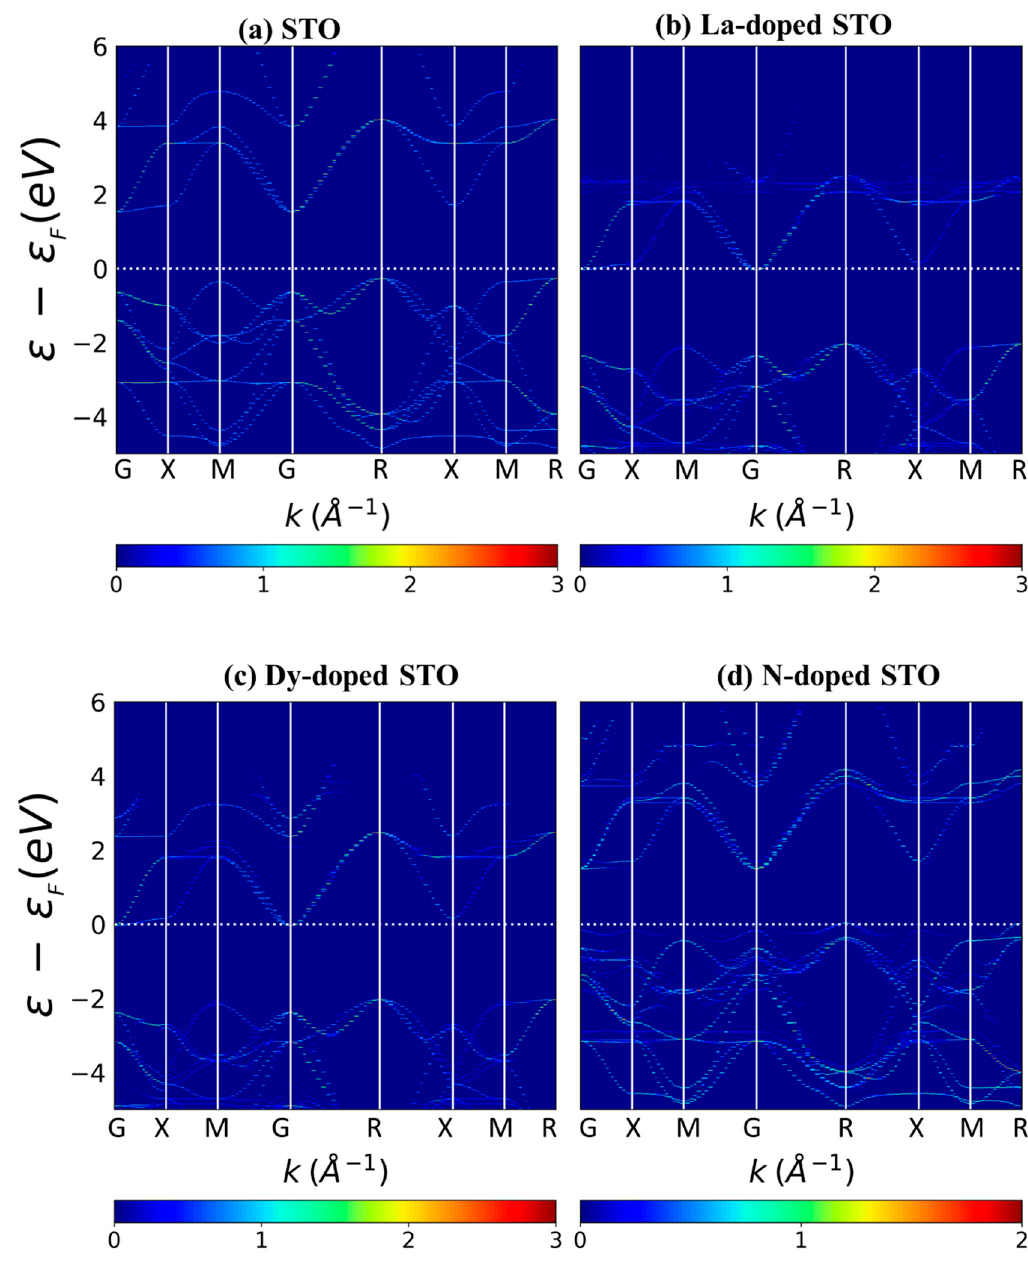
Figure 5. Band structures of ( a ) undoped SrTiO 3 , ( b ) La-doped SrTiO 3 , ( c ) Dy-doped SrTiO 3 and ( d ) N-doped SrTiO 3 , where white dashed lines denote the Fermi level, set to zero. The DOS scale is shown at the bottom of each figure.